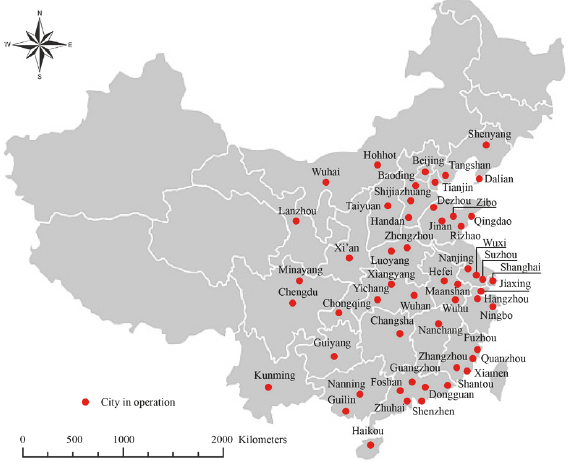
Figure 1: Spatial distribution of main dockless bike-sharing systems in